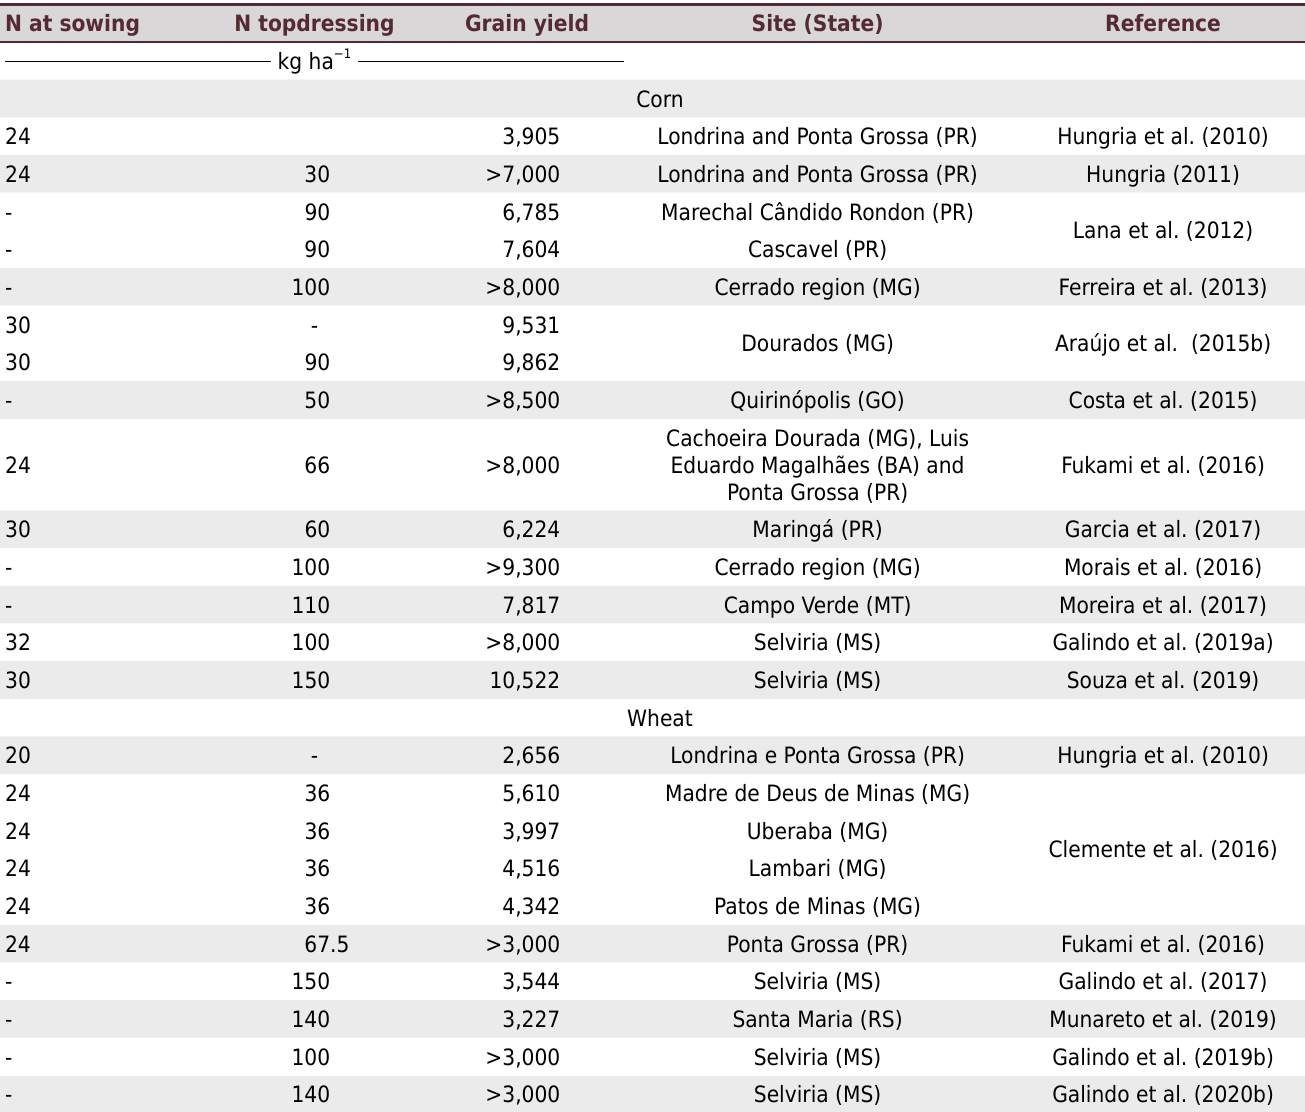
Table 1. Studies reporting benefits of inoculation with Azospirillum brasilense strains Ab-V5 and Ab-V6 in maize and wheat, and grain yield levels achieved in Brazil with different supplies of N-fertilizer N at